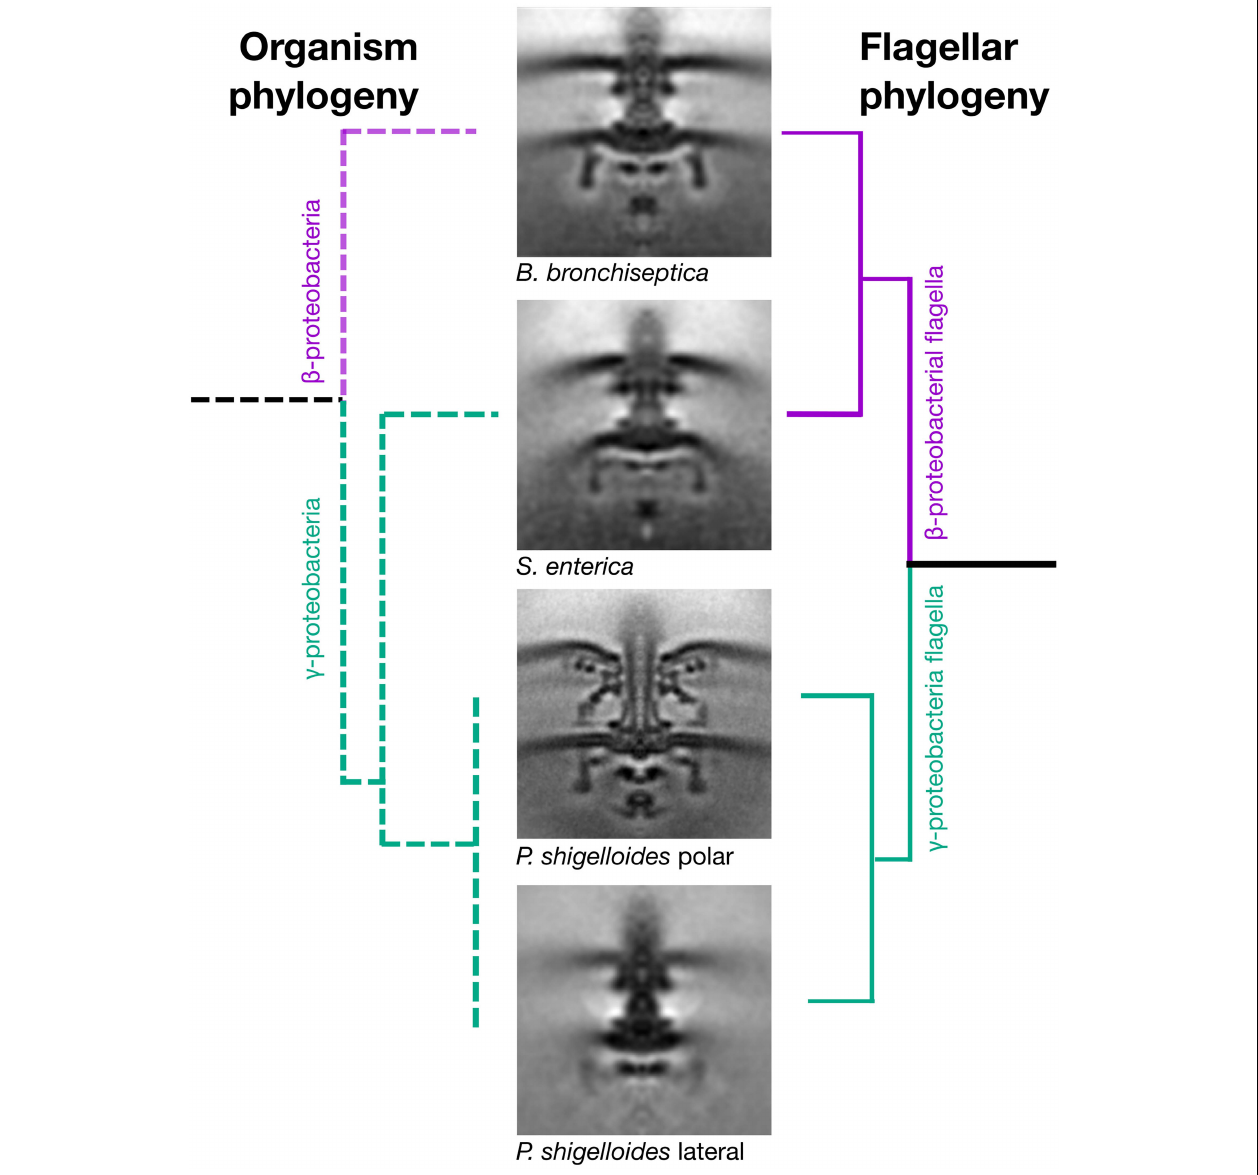
FIGURE 2 | Horizontal transfer of flagellar genes is confirmed by cryo electron tomography and subtomogram averaging. Subtomogram averages of the “donor” ( Bordetella bronchiseptica ) and “acceptor” ( Plesiomonas shigelloides ) strains confirms that the γ -proteobacterium, Salmonella enterica, has a flagellar motor that is structurally similar to the β -proteobacterium, B. bronchiseptica, and structurally distinct from the two motors of its close relative, the γ -proteobacterium P. shigelloides. The organism phylogeny (left) and flagellar phylogeny (right) are inconsistent as the γ -proteobacterium, Salmonella enterica, has a β -proteobacterial motor. Middle: Subtomogram averages of B. bronchiseptica (EMD-4999), S. enterica (EMD-3154), P. shigelloides polar motor (EMD-10057) and P. shigelloides lateral motor (EMD-10000). Note the faint C-ring density in the lateral motor. Subtomogram average boxes are 100 × 100 nm. Unsymmetrized structures are shown in Supplementary Figure S7